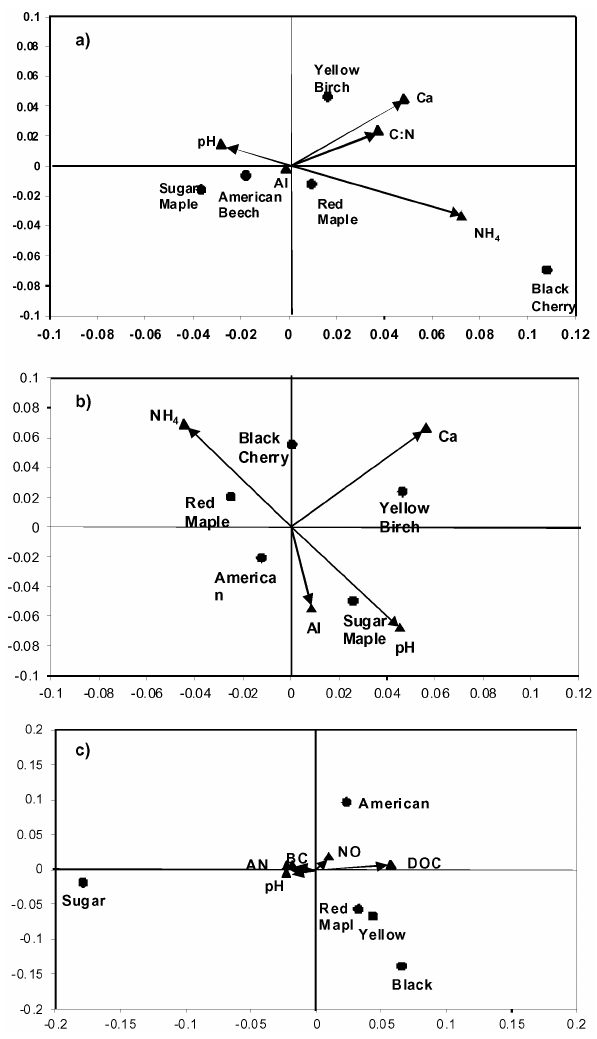
Fig. 5. CCA biplots with tree species basal area (m 2 ha − 1 ) rep- resented by circles and environmental variables. The environ- mental variables (arrows) are (a) forest floor pH (units), NH 4 (µmolNg − 1 ), Ca (mgg − 1 ), Al (mgg − 1 ) and C:N (molar ratio); (b) mineral soil pH (units), NH 4 (µmolNg − 1 ), Ca (mgg − 1 ) and Al (mgg − 1 ); and (c) stream sample pH (units), NO − DOC (µmolCL − 1 ), ANC c (µeqL − 1 ) and BCS (µeqL − 1